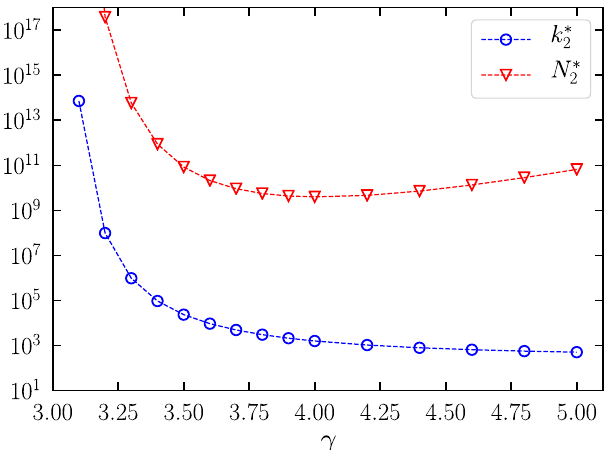
FIG. 4. Values of the crossover degree k (cid:2) 2 and the minimal γ − 1 Þ γ . In order to observe network size N (cid:2) 2 ¼ k (cid:2)ð 2 as a function of the crossover, networks of size N ≫ N (cid:2) 2 should be